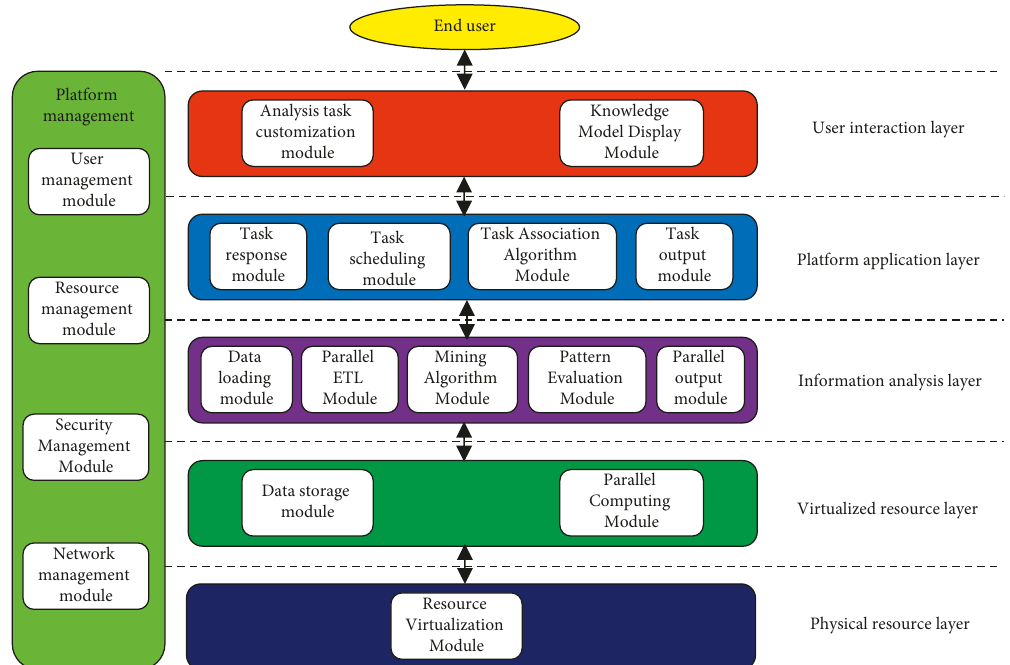
Figure 2: Logical architecture of logistics information intelligent analysis application platform based on cloud